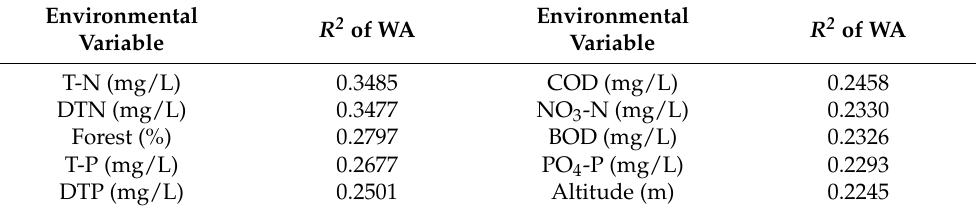
Table 5. Ten environmental variables with a high R 2 value.